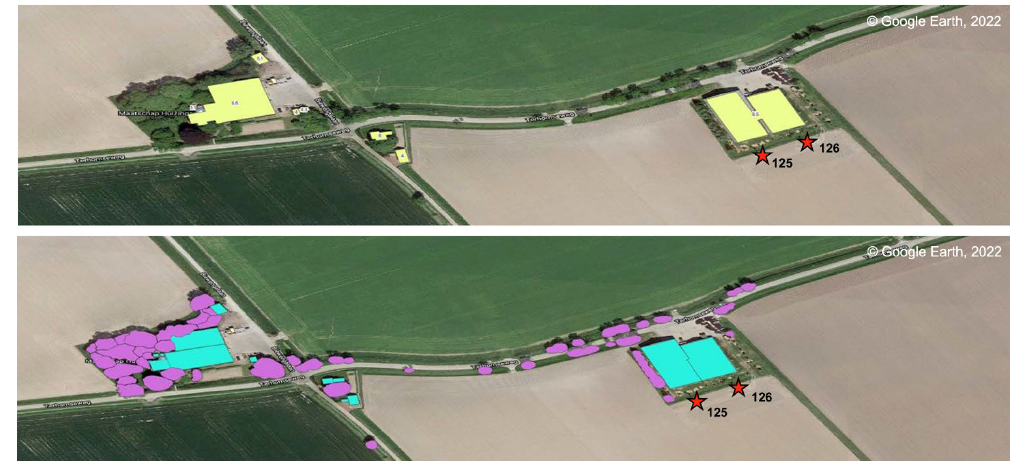
Figure 3. Top panel: obstacle annotations for a site with two turbines using data commercially available from 3dBuildings.com. Bottom panel: full annotations using a semi-automated annotation process including both buildings and vegetation, enriched with lidar data.